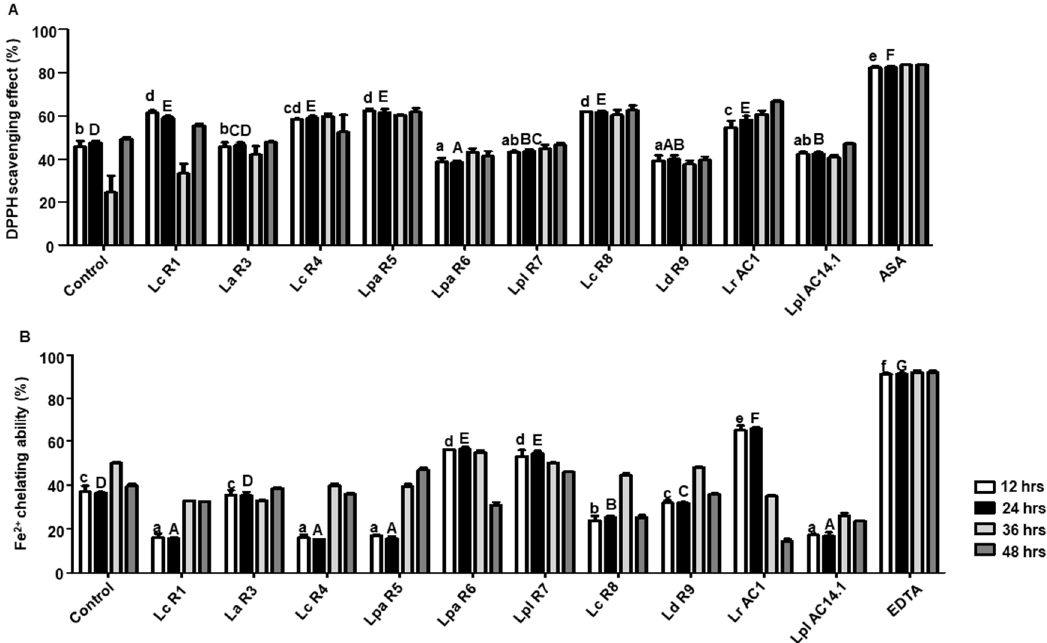
Figure 11. Antioxidant capacities of soymilk fermented by LAB isolates at different time points during fermentation in vitro. Measurement of superoxide anion radical scavenging ability ( A ); Measurement of ferrous ion-chelating ability ( B ). 1 mg/mL of ascorbic acid (ASA) and 0.5 µg/mL of EDTA were used as positive controls for DPPH scavenging effect and Fe 2+ -chelating ability, respectively. Lower case letters represent the comparisons of results of groups after 12 h fermentation. Upper case letters represent the comparisons of results of groups after 24 h fermentation. Lc, L. casei; La , L. acidophilus; Lpa , L. paracasei; Lpl , L. plantarum; Ld , L. delbrueckii; Lr , L. rhamnosus; Ls , L. sakei; Leu , Leu. mesenteroides.